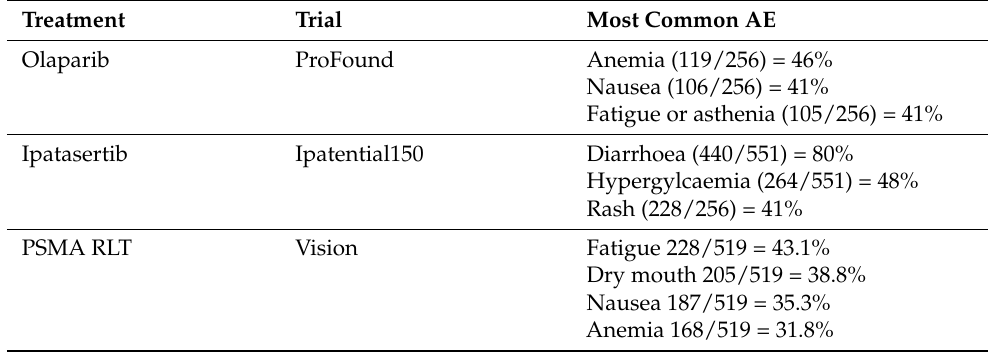
Table 7. Most common adverse events related to molecular